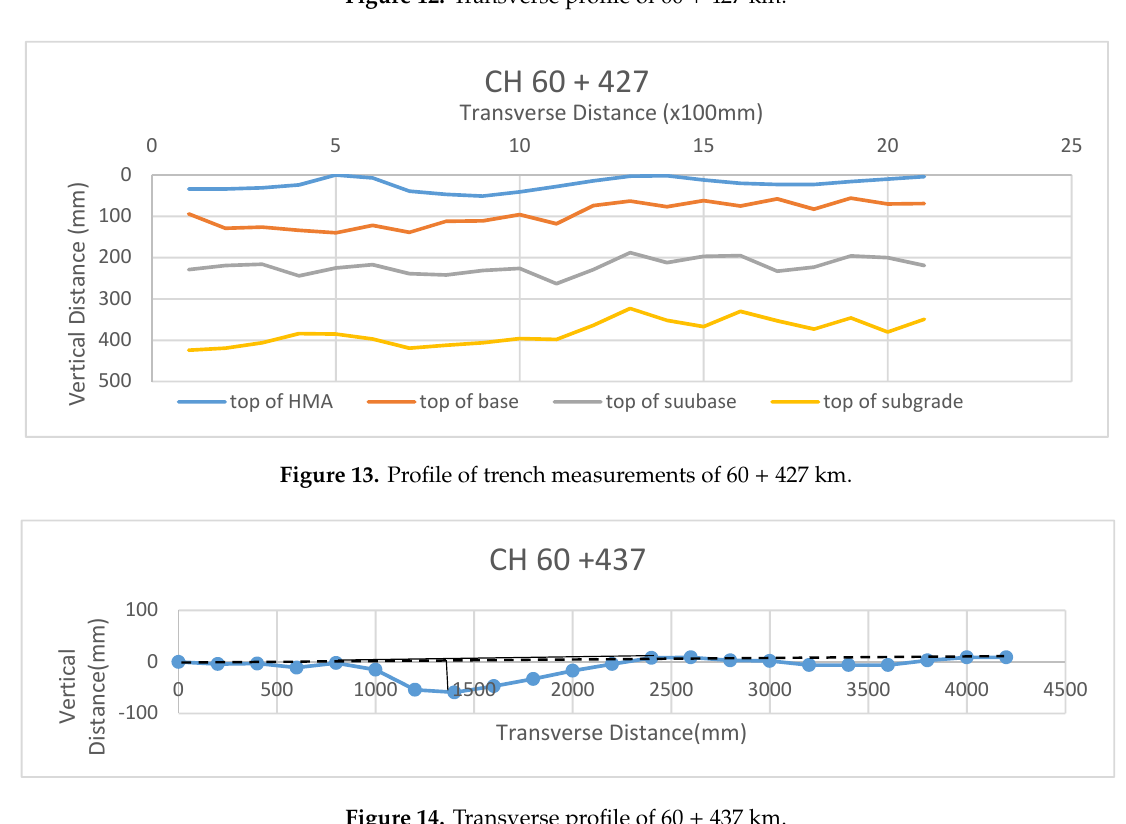
Figure 14. Transverse profile of 60 + 437